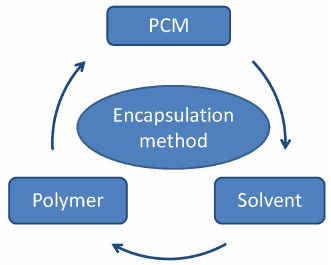
Figure 3. Material selection influencing an encapsulation method.